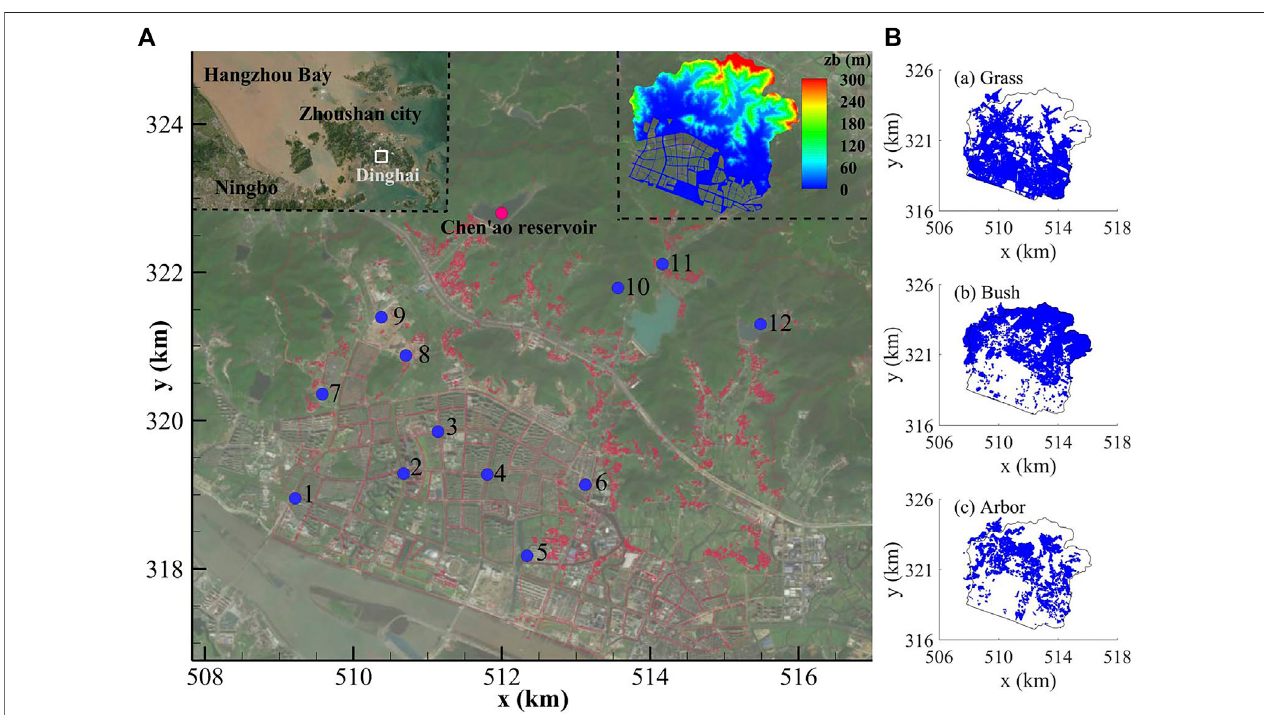
FIGURE 2 | (A) Study area, topography and selected points (B) vegetation types.